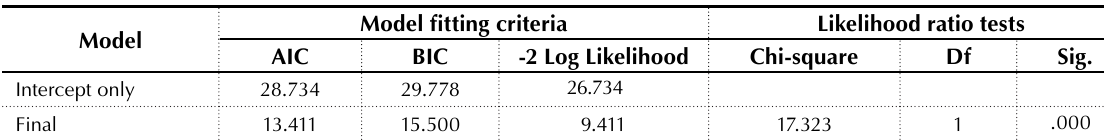
Table 23. Model fitting information of stable